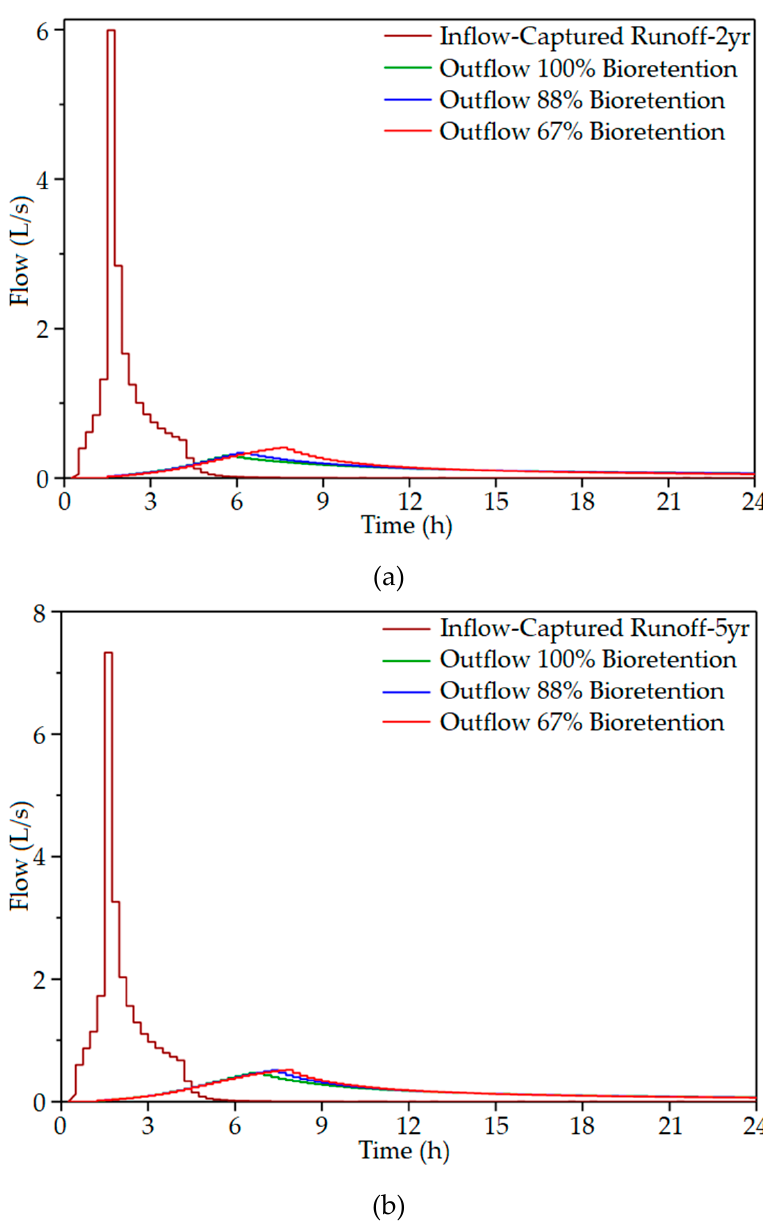
Figure 14. Inflow and outflow hydrographs of RBR for 12, 16, 18 m of length ( a ) 2-year; ( b ) 5-year.